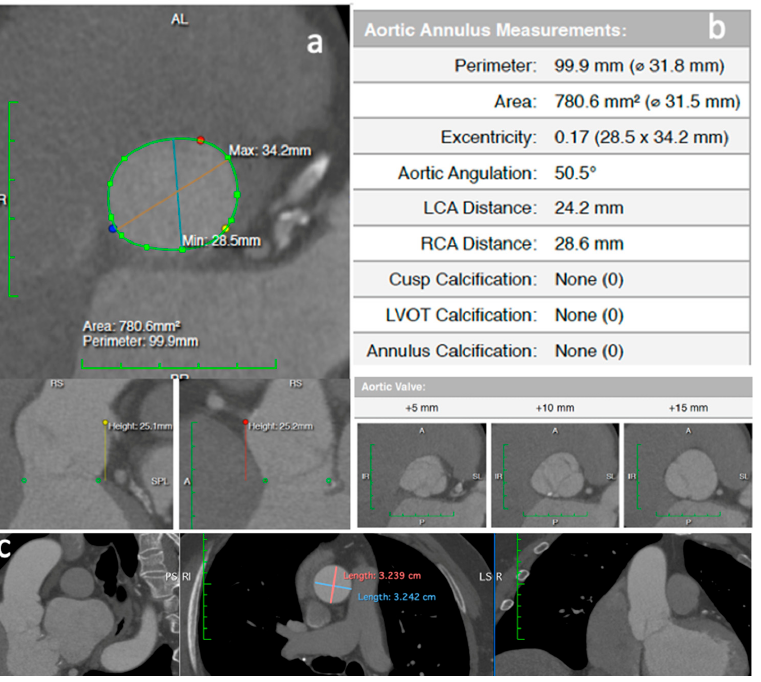
Figure 2. A preoperative computed tomography evaluation ( a ) showing large annulus (area 780 mm 2 , perimeter 99 mm) ( b ) and normal ascending aorta dimensions ( c ).